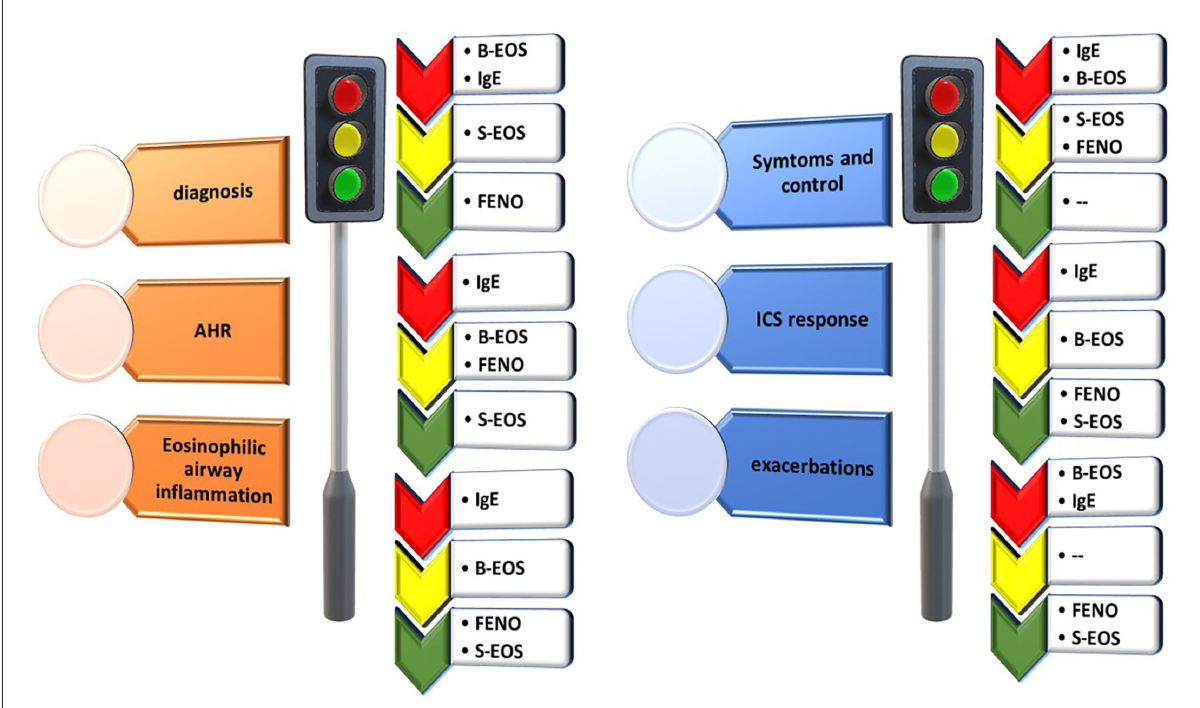
FIGURE2 Strengths and weaknesses of asthma biomarkers in clinical practice. Red light: Poor evidence; yellow light: Debated/to be improved; green light: Good